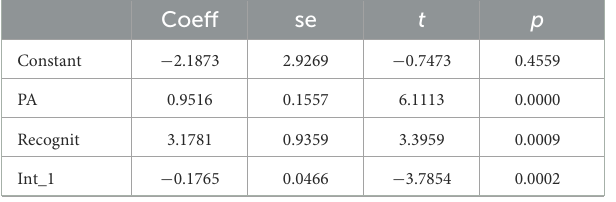
TABLE 9 Deep Acting and Personal Accomplishment, with recognition as the moderator. Coeff se t